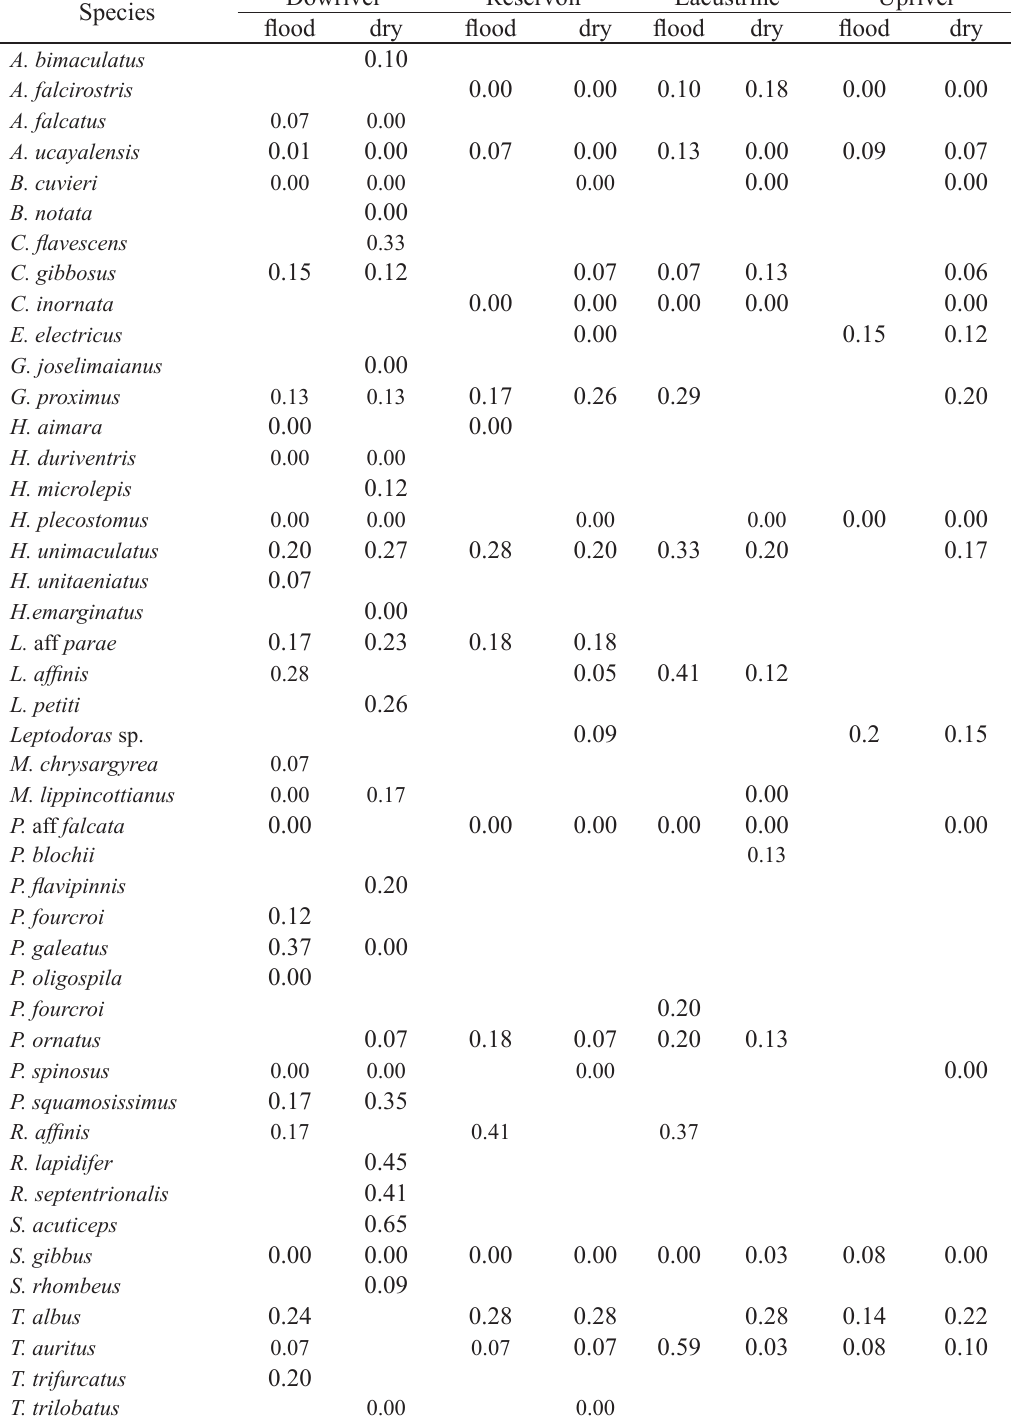
Niche breadth (Bi) values of species analyzed in the areas under influence of Coaracy Nunes Dam (Amapá State,